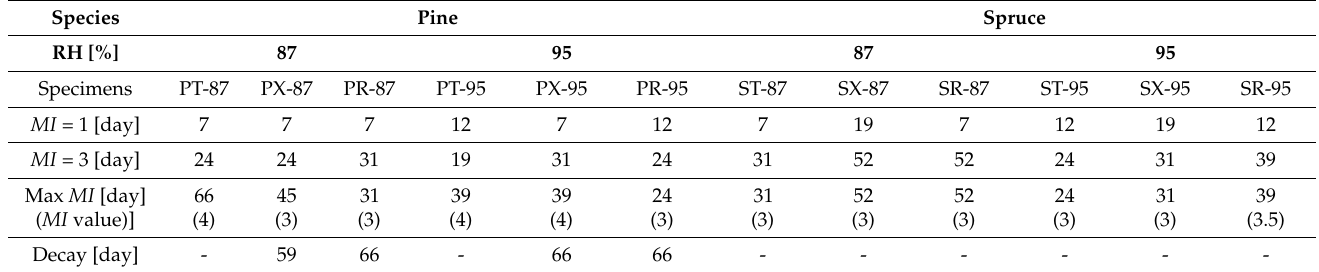
Table 4. Characteristic times in mold growth on test specimens. The values are expressed in days and represent: MI = 1, the time of the first microscopic signs of the growth; MI = 3, the time of the first macroscopic signs of growth; Max MI , the time when the mold index was achieved and its value in brackets; Decay, the time when the decay of sporangium maximum was first